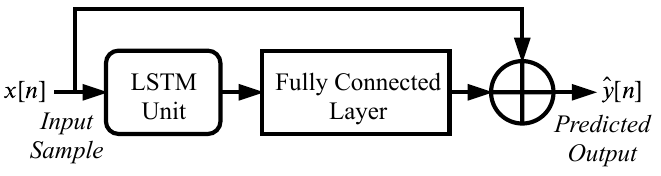
Figure 9. Recurrent neural network